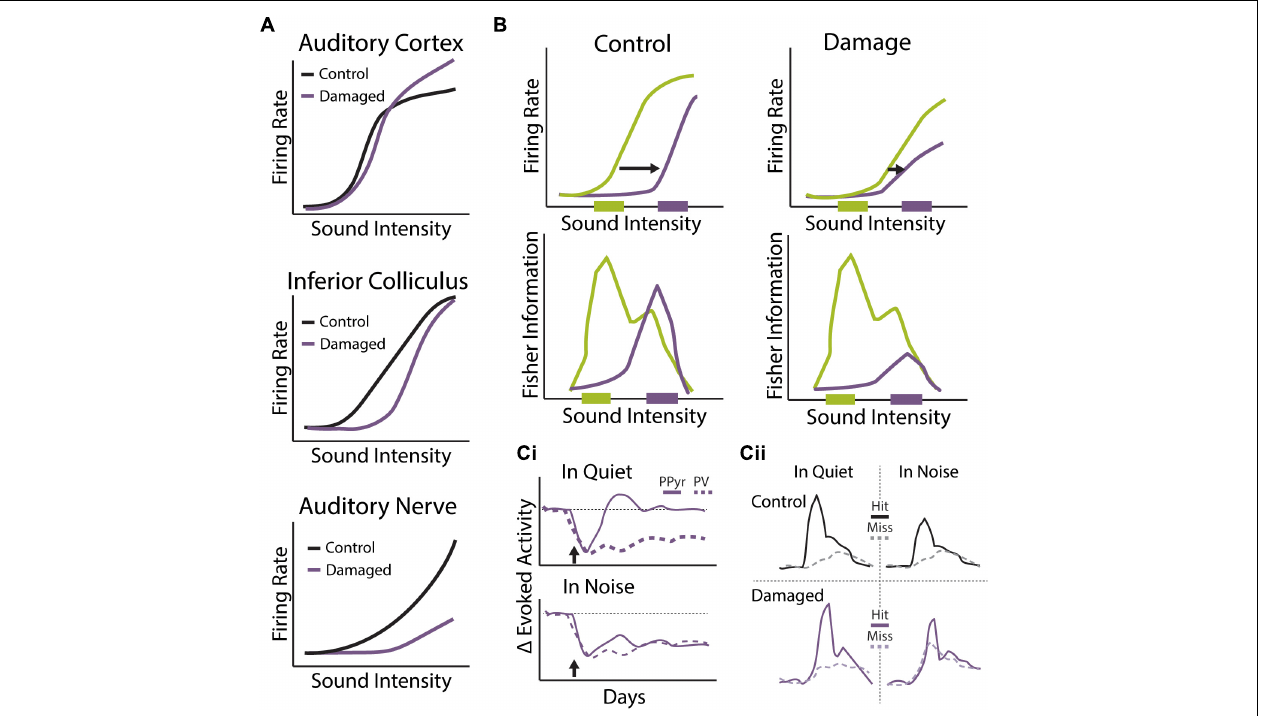
FIGURE 5 | Central gain enhancement following sensorineural hearing loss. (A) Schematics of rate-intensity functions from multiple levels of the auditory system under control conditions (black) or following cochlear damage via noise or ototoxic drug exposure that results in the central gain enhancement (purple). While output from the AN is severely degraded in terms of evoked-response threshold and suprathreshold intensity coding, rate-intensity functions gradually recover at ascending levels of the auditory system so that thresholds and suprathreshold responses are nearly normal at the level of the ACx and, in some cases, exhibit rebound hyperactivity. (B) Mean sound level adaptation to loud sound environments is altered with noise-induced hidden hearing loss. Rate-intensity functions from the IC of control (left) and noise exposed (right) mice when exposed to dynamic sound stimulus that switches between distributions with high probability of low sound levels (green) and high probability of high sound levels (purple). Noise exposed animals exhibit less dynamic range adaptation (top) and response functions carry less information about loud sound environments (bottom) compared to control animals. Schematized data adapted from Bakay et al. (2018). (Ci,ii) Cochlear degeneration triggers compensatory changes to cortical excitatory/inhibitory balance that differentially effects tone detection in quiet and noise. (Ci) Distinct changes to tone-evoked calcium transients in putative excitatory pyramidal neurons (PPyr, solid lines) and genetically-labeled PV inhibitory neurons (dashed lines) in the ACx following ouabain induced cochlear degeneration (arrow). Following transient loss of evoked activity, PPyr neurons exhibit near complete recovery of evoked-response size in quiet but not in background noise. Sustained decreases to tone-evoked activity in PV neurons are observed following ouabain treatment in both quiet and noise conditions. (Cii) Combined behavioral and imaging sessions showing differences in tone-evoked responses in cortical PPyr neurons on hit (solid lines) vs. miss (dashed lines) trials in quiet or background noise from animals before (control, black) and after ouabain-induced cochlear degeneration (damaged, purple). Decreased tone-in-noise detection in ouabain-treated animals is not only associated with diminished tone-evoked responses on hit trials but also increased activity on miss trials. These results suggest that altered E/I balance in the ACx following cochlear degeneration may lead to impaired adaption to background noise and decreased signal-to-noise ratios for detection of foreground stimuli. Schematized data adapted from Resnik and Polley